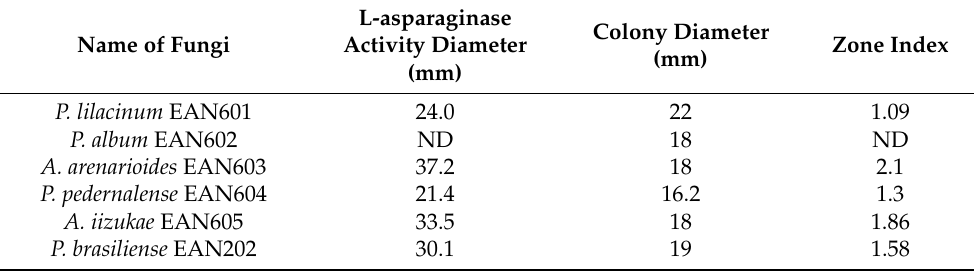
Table 1. L-asparaginase activity diameter, colony diameter, and zone index of L-asparaginase produced from six fungal strains in the